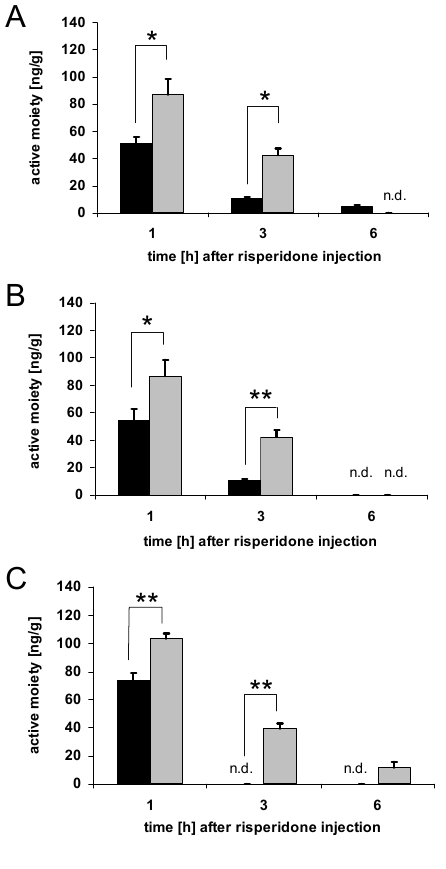
Figure 3. Brain concentrations of risperidone active moiety. Brain concentrations of the active moiety of risperidone and 9-hydroxyrisperidone after drug transporter induction with 10 mg/kg/d rifampicin (A), 50 mg/kg/d dexamethasone (B) or 25 mg/kg/d PCN (C) vs. controls for 4 days. Drug transporter-induced mice = black, and controls = grey. Data are mean + /- S.E.M. n.d. = data not detectable due to drug concentrations below limit of quantification, and set to zero for statistical calculations (* p < 0.05; ** p <